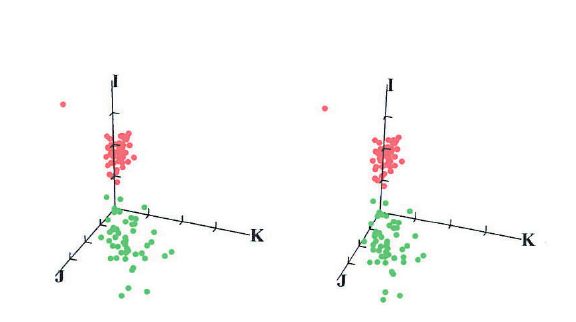
Figure 1. A scatter plot of 50 measurements taken under light (red data points), and 50 measurements taken under dark (green data points) conditions. The difference in posi- tion of the red points as opposed to the green points is a result of the dark refraction shift. The axis length in the figure is 1 D. The origin of this, and all other figures, is set at plano.